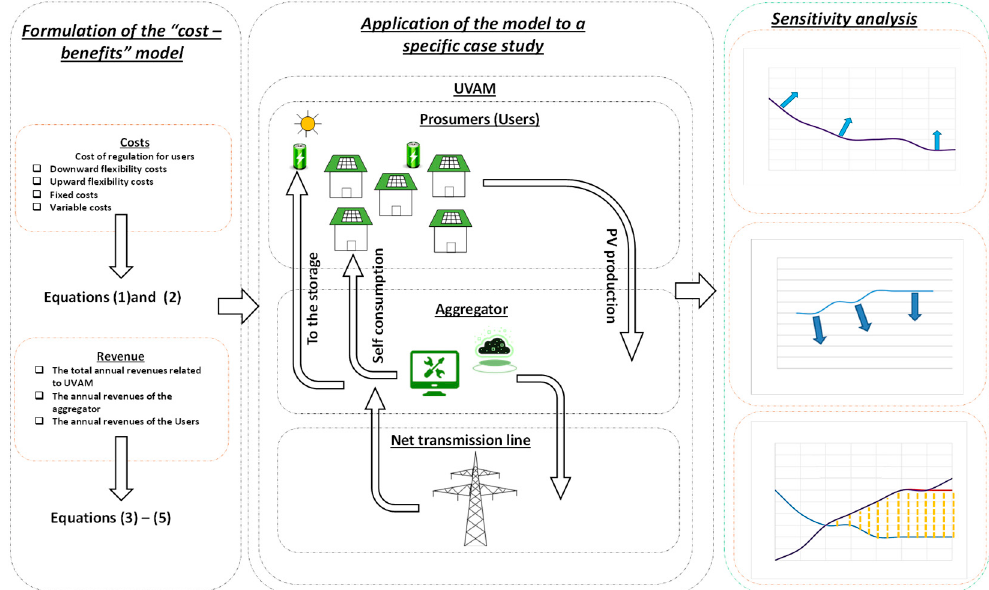
Figure 4. Flow-chart of the model applied.